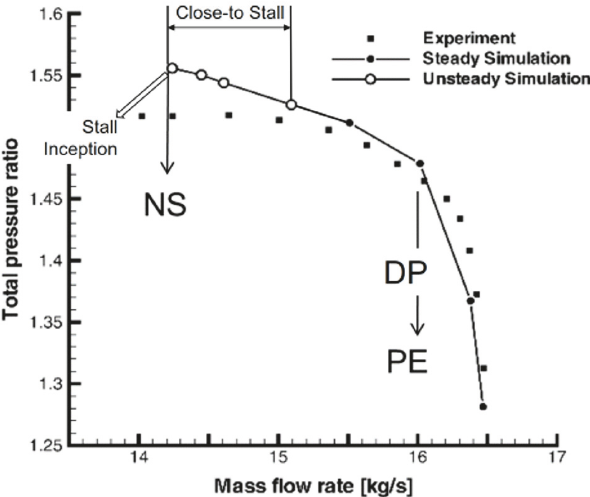
Figure 1: The comparison of experimental and computational characteristics of Darmstadt Rotor 1 ([12]). Several technical terms are also illustrated. Figure reproduced from LIN et al.